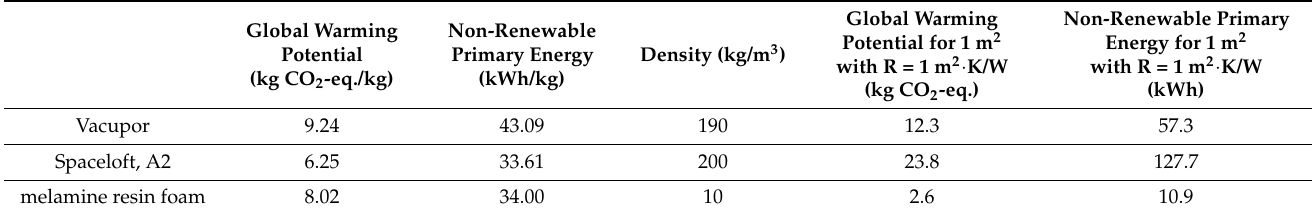
Table 4. Summary of environmental product declaration for Porextherm Vacupor VIP [42], Aspen Spaceloft A2 aero- gel blanket [43] and melamine resin foam [44] and performance-based global warming potential and non-renewable primary